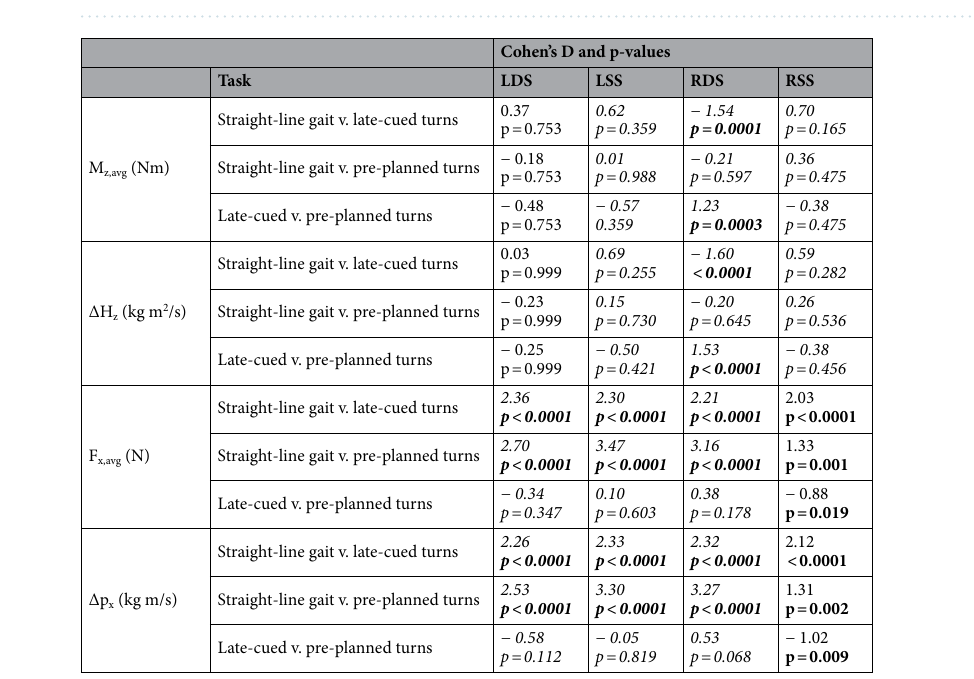
Figure 7. Two example late-cued turn trials classified as a spin turn (top) and a step turn (bottom) performed by the same participant with indications of the gait phases that generated the largest ( a ) − X linear and transverse-plane angular momentum, ( b ) change in − X linear and transverse-plane angular momentum, ( c ) average − X linear force and average moment about vertical. During the spin turn, the left single support generated the largest change in COM leftward momentum and largest average leftward (− X) linear force. During the step turn, the right single support generated the largest change in leftward (− X) force and largest average COM leftward linear acceleration. Additionally, during both the step turn and the spin turn, the left double support (double support with the left foot in front) generated the largest change in transverse-plane angular momentum and largest average moment about vertical.